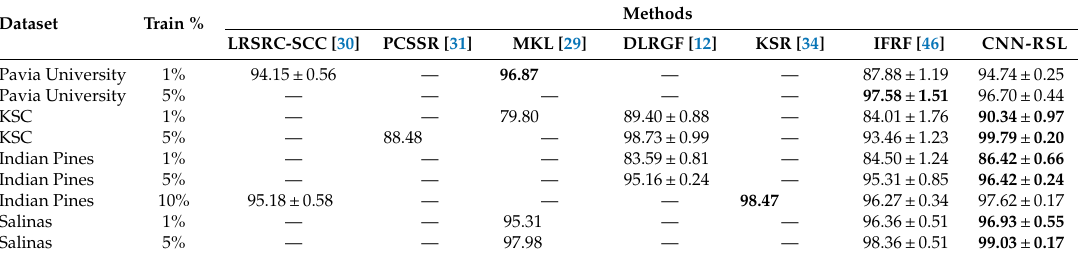
Table 10. Average classification accuracy reported on other experimental settings used in the literature. We considered the following methods: Low-Rank and Sparse Representation Classifier with a Spectral Consistency Constraint (LRSRC-SCC), Probabilistic Class Structure Regularized Sparse Representation (PCSSR), Multiple Kernel Learning (MKL), Discriminative Low-Rank Gabor Filtering (DLRGF), Kernel Sparse Representation (KSR), Image Fusion and Recursive Filtering (IFRF) and our method (CNN-RSL). The best accuracy for each dataset and % training samples employed is indicated in